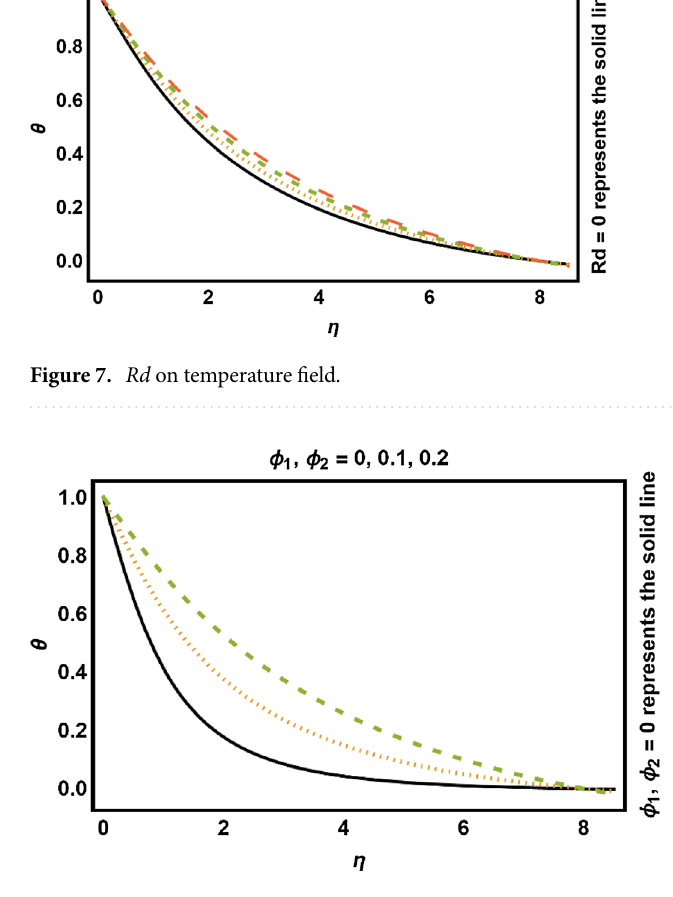
Figure 8. ϕ 1 , ϕ 2 on temperature field.